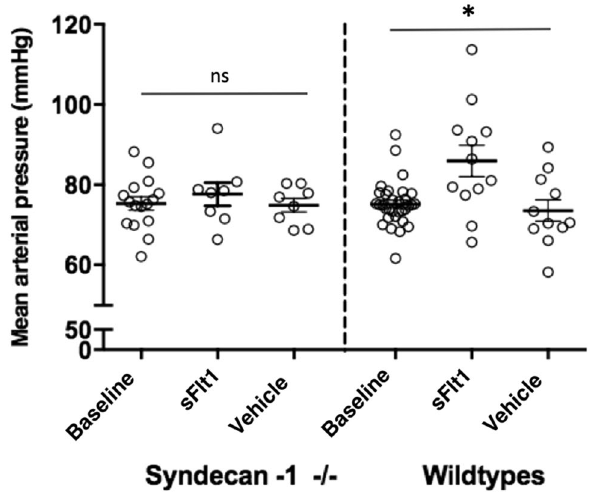
Figure 4. Effect of sFlt1 and vehicle on blood pressure of syndecan-1 deficient mice and wild type controls. Effect of sFlt1 or vehicle infusion during two weeks on mean arterial blood pressure (MAP) of syndecan-1 deficient mice and wild type controls. Syndecan-1 deficient mice have similar MAP at baseline (N = 16) and after treatment with sFlt1 (N = 8) and vehicle (n = 8). Treatment with sFlt1 significantly elevates MAP in wild type control mice (N = 12) compared to baseline (N = 32) and vehicle (N = 11) treatment. Bars represent mean ± SEM, ns indicates not-significant, * indicates p <